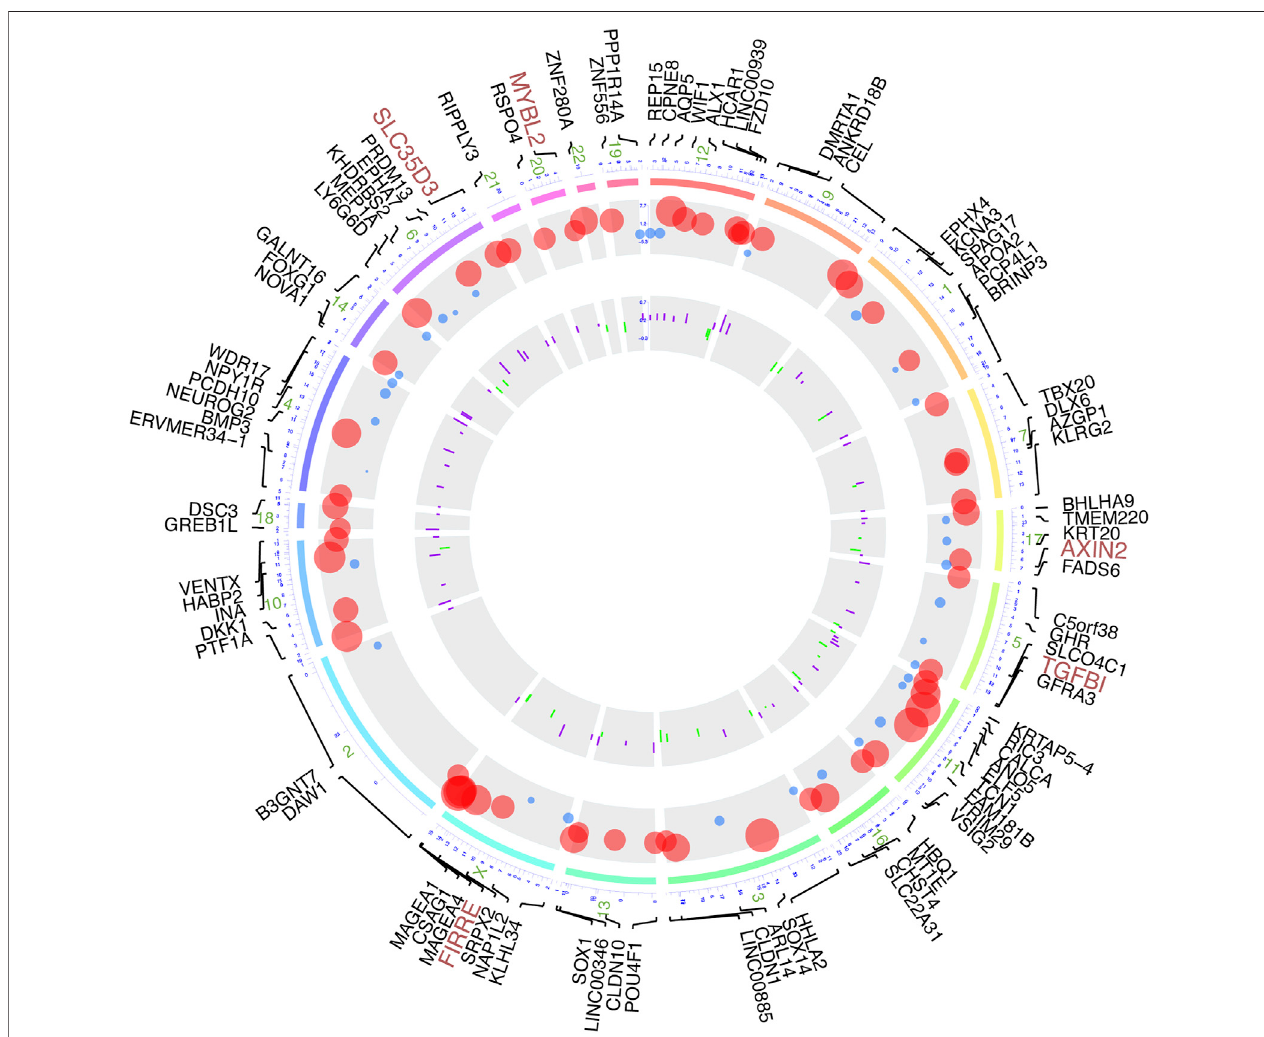
FIGURE 3 | Circos plot of DNA methylation-driven genes based on multi-omics. From outermost circle to inner circle, presentation on map is as follows: chromosome location with lines deriving from speci fi c gene locus, log 2 FC of transcriptome expression by dot plots with size of dots proportional to value and with red showing high expression and blue showing low expression, and log 2 FC of DNA methylation by bar charts provided with purple indicating hypermethylation and green indicating hypomethylation.